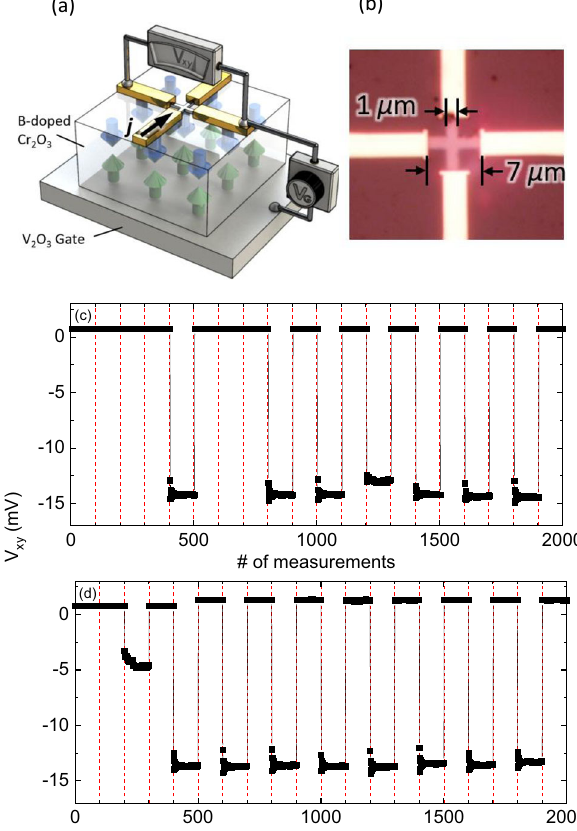
Fig. 2 Image of the lithographically patterned device, illustration of the experiment, and switching results. a Cartoon of Hall bar device showing V 2 O 3 back gate, B-doped Cr 2 O 3 fi lm with AFM spin structure, Pt Hall cross with Au electrodes, current density j fl owing in direction of black arrow causing signal V xy which depends on applied voltage V G . b Optical image of the device with 7.0 μ m × 1.0 μ m legs forming the Pt Hall cross with attached Au electrodes on top of the B-doped Cr 2 O 3 fi lm. c and d show V xy versus the number (#) of measurements. Vertical dashed lines indicate respective application of a voltage pulse V G = ± 25 V. Measurements are done at T =